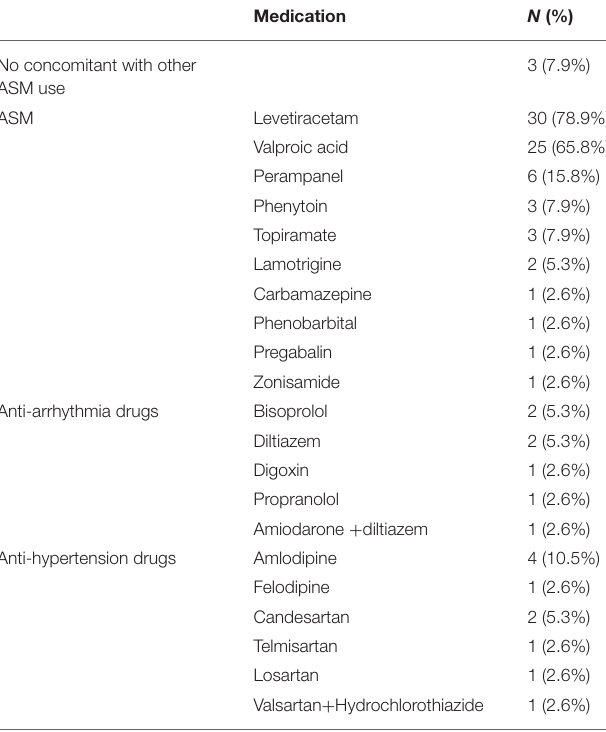
TABLE 3 | Usage of lacosamide and side effects. Usage of